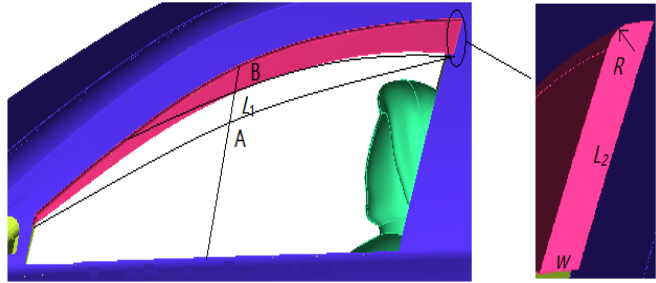
Figure 8. Optimization parameters of the visor.